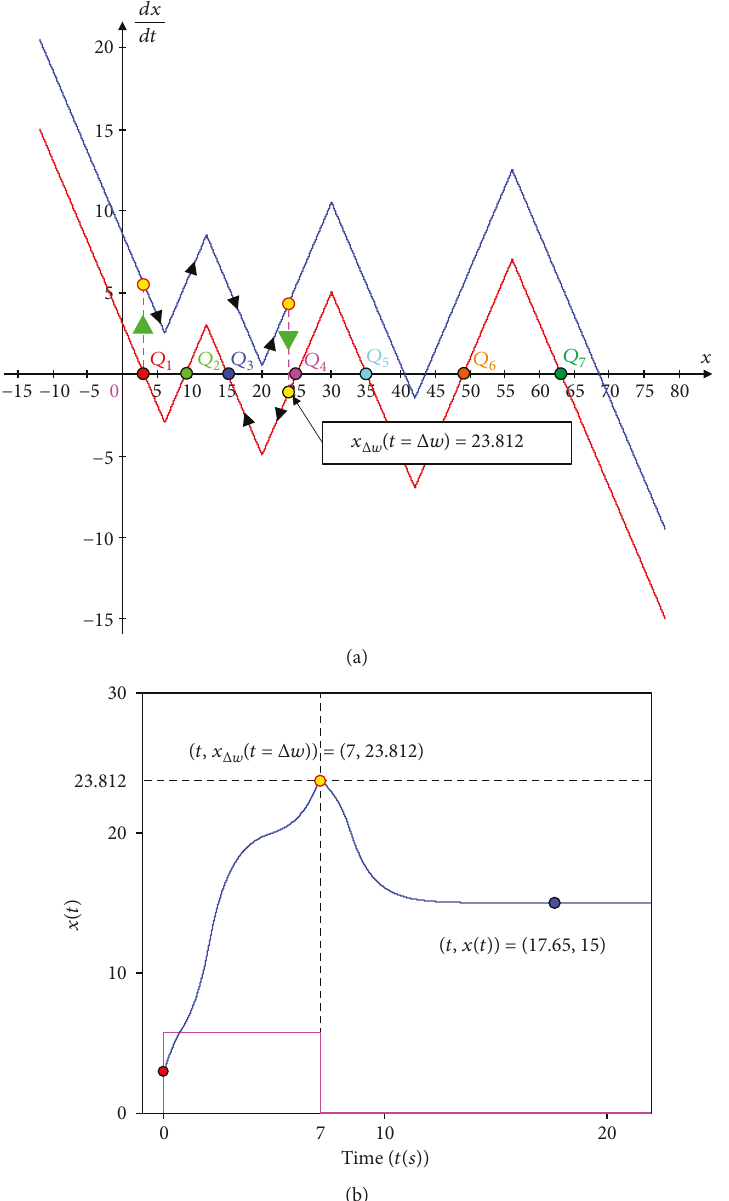
Figure 8: Switching failures of the 6-lobe corsage memristor from Q Dynamic routes of the switching kinetics and (b) movement of the exponential trajectories of x t with respect to time t . The switching failure happens due to insu ffi cient pulse